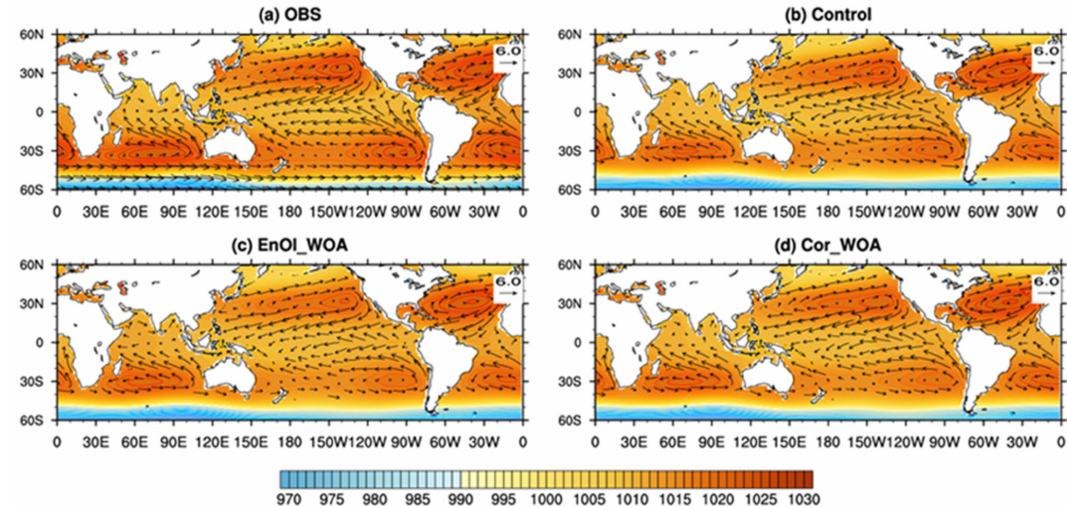
Figure 4. Long-term mean distribution of the global sea level pressure (unit: hPa) and surface wind (unit: m/s). ( a – d ) represent OBS, Control, EnOI_WOA, and Cor_WOA.